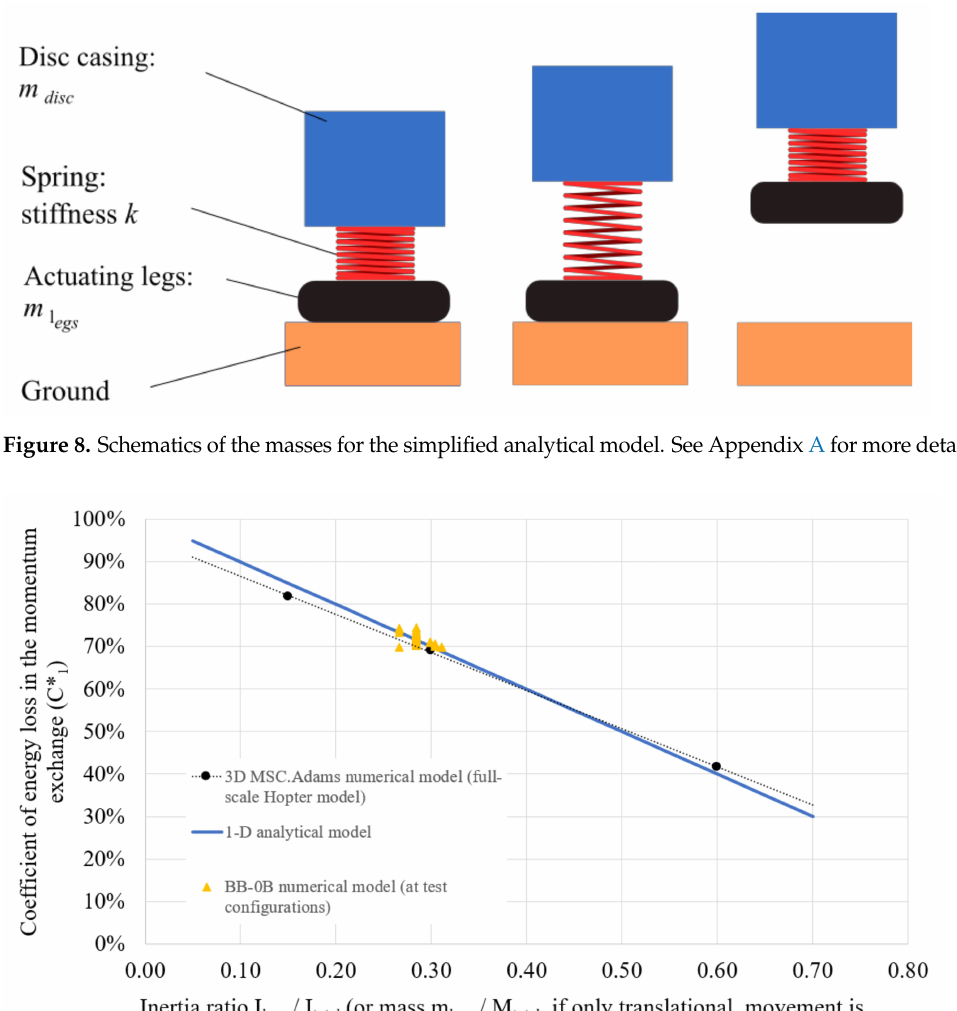
) against mass ratio of the mass of legs ( m legs ) to total mass of 1